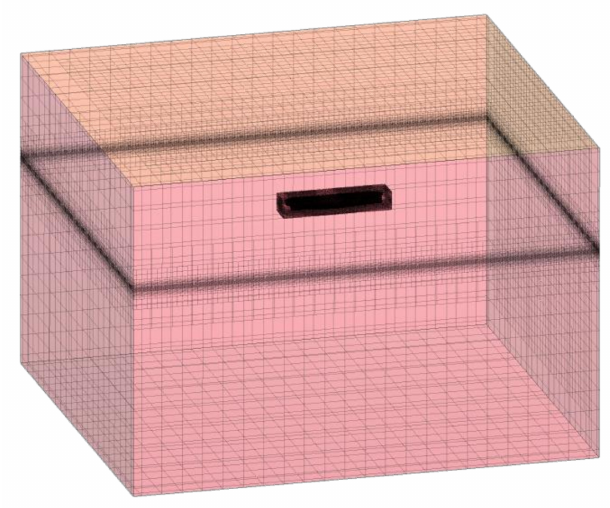
Figure 6. General view of meshes in fluid